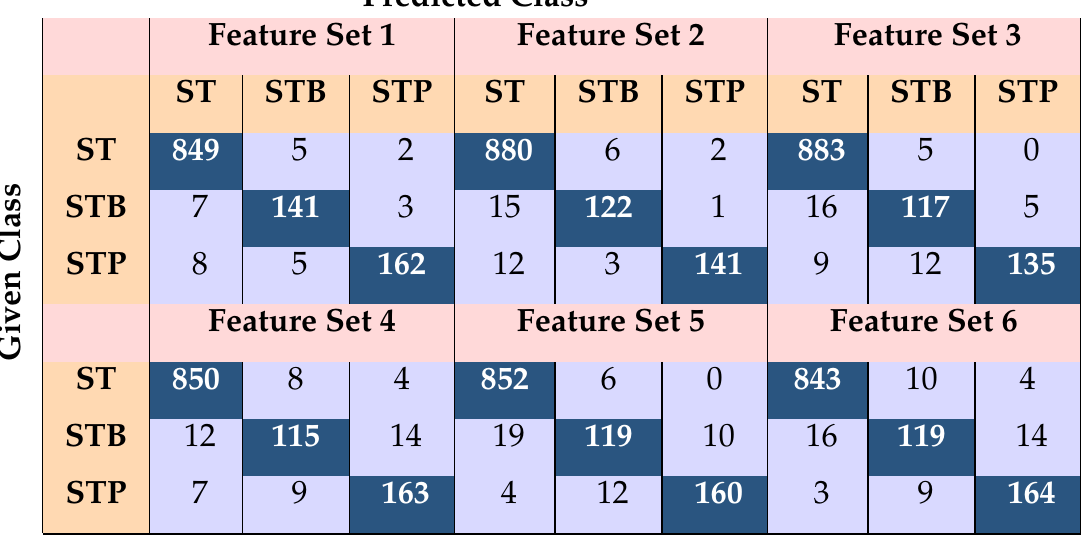
Table 6. The confusion metrics of the random forest classifier over the 12-second window size on six feature sets at the right-hand (RH) position.